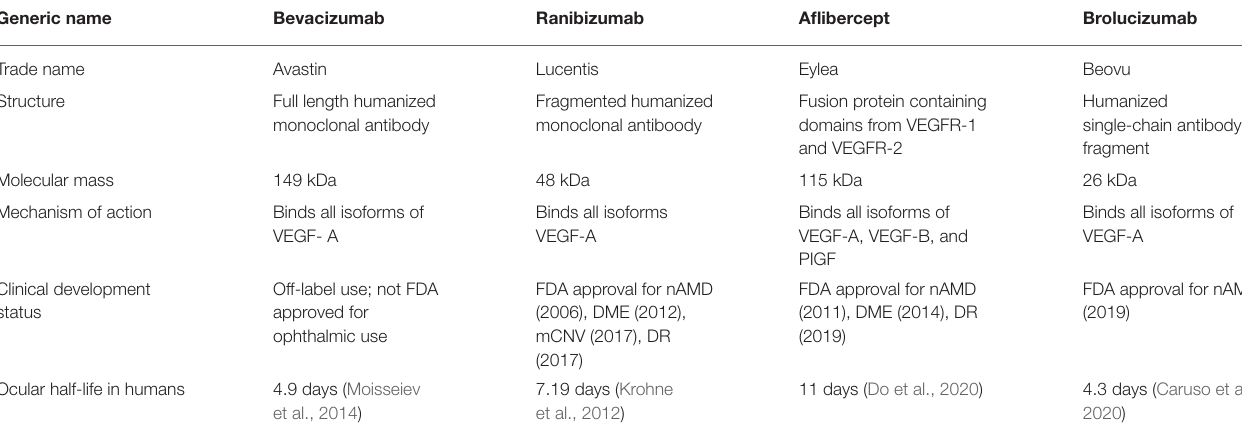
TABLE 1 | A summray of current anti-VEGF